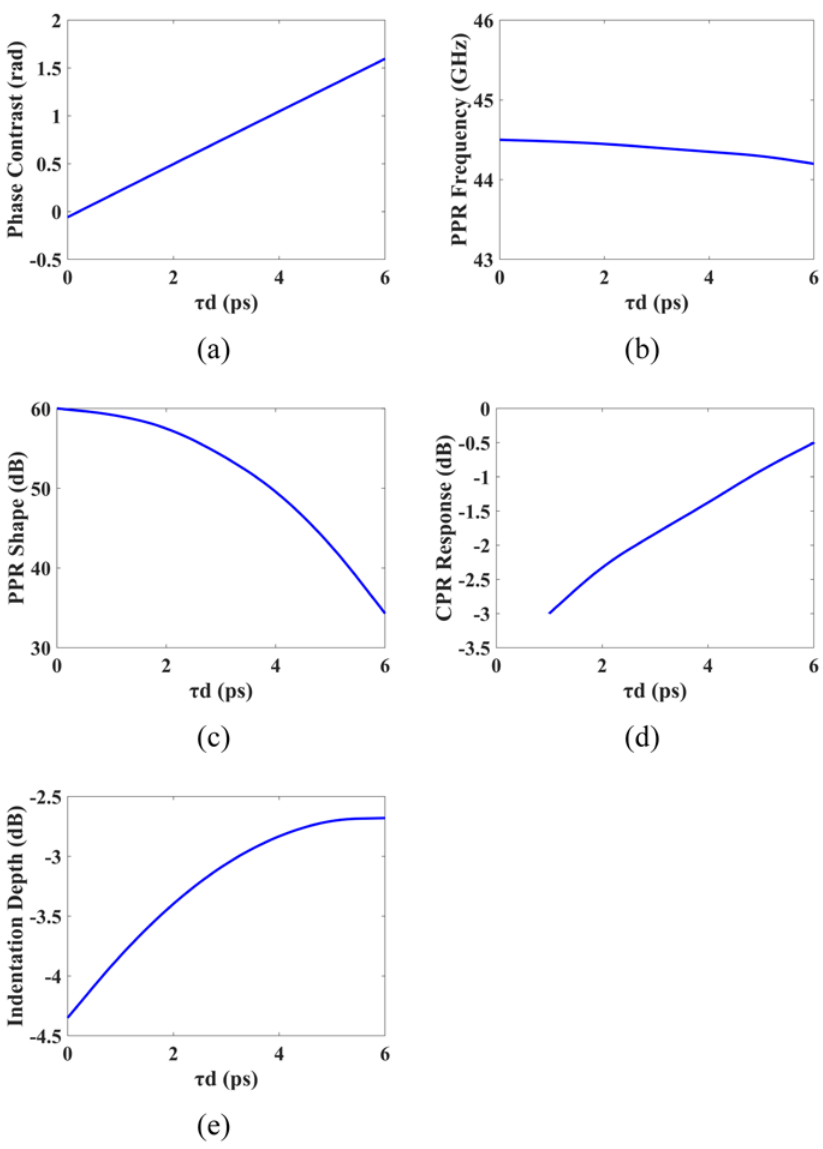
Figure 8. The effect of delay time τ d : ( a ) Phase contrast between modulation responses vs. τ d ; ( b ) PPR frequency vs. τ d ; ( c ) PPR shape factor vs. τ d ; ( d ) CPR response vs. τ d ; ( e ) Indentation depth vs. τ d .